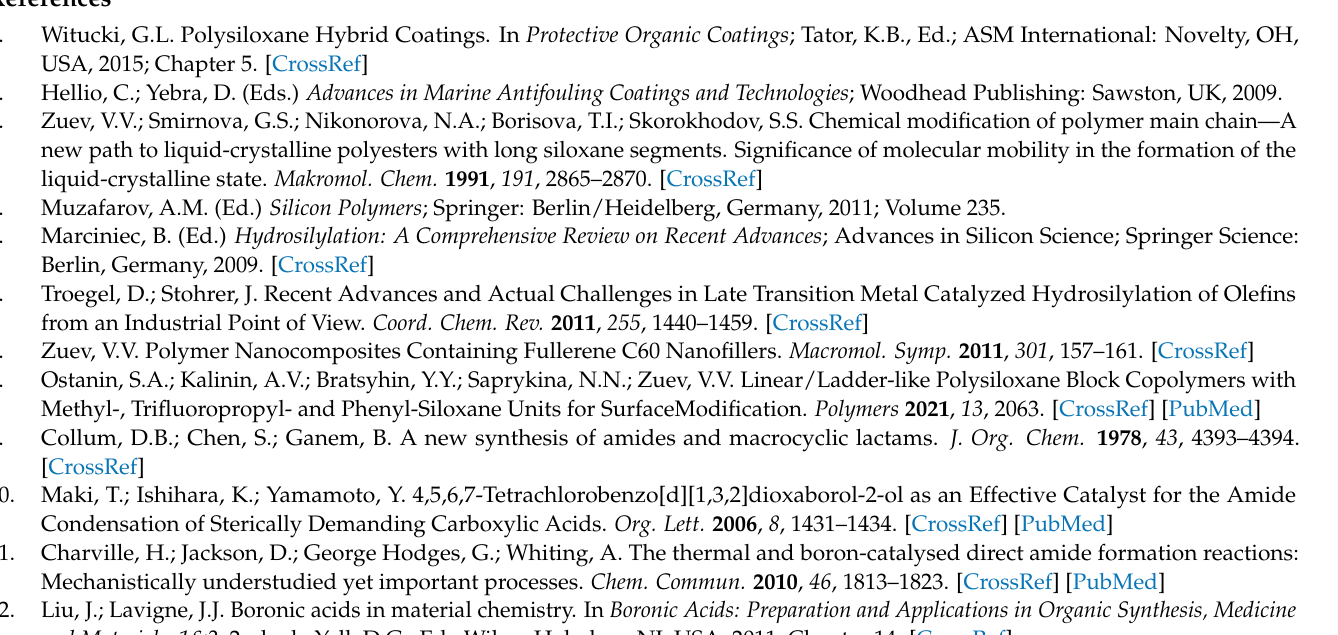
solution. Figure S3. Mechanical testing of copolymer III before modification. Figure S4. Mechanical testing of copolymer III after modification. Figure S5. The chromatogram of copolymer IV before heating (starting copolymer). Figure S6. The chromatogram of copolymer IV after heating at 132 ◦ C in chlorobenzene at 6